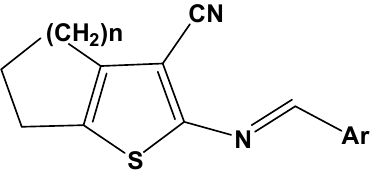
Figure 1. General structure of the studied 2-aminothiophenes.